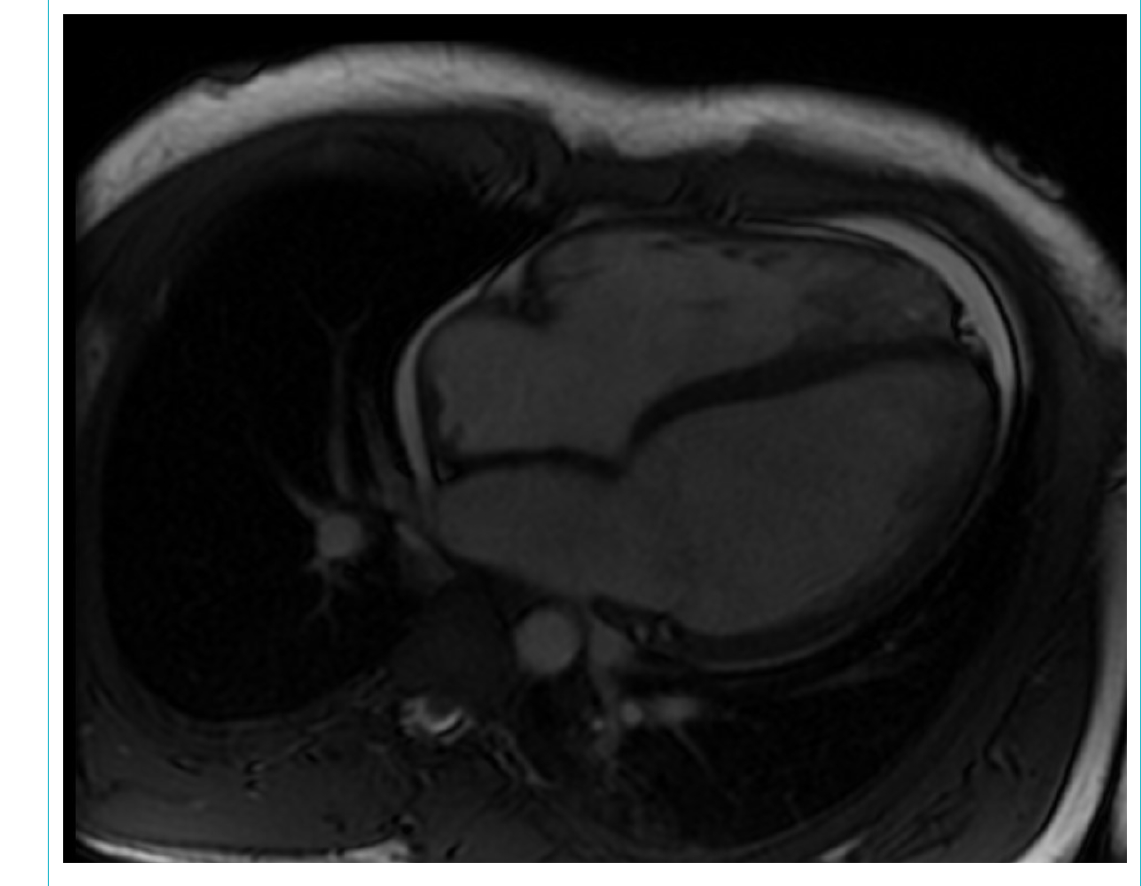
Figure 3: Four-chamber view of the magnetic resonance imaging examination in a 1.5 T scanner. Both ventricles are dilated, and ejection fractions are markedly reduced (left ventricular ejection fraction 31%, right ventricular ejection fraction 42%). There was a pericardial